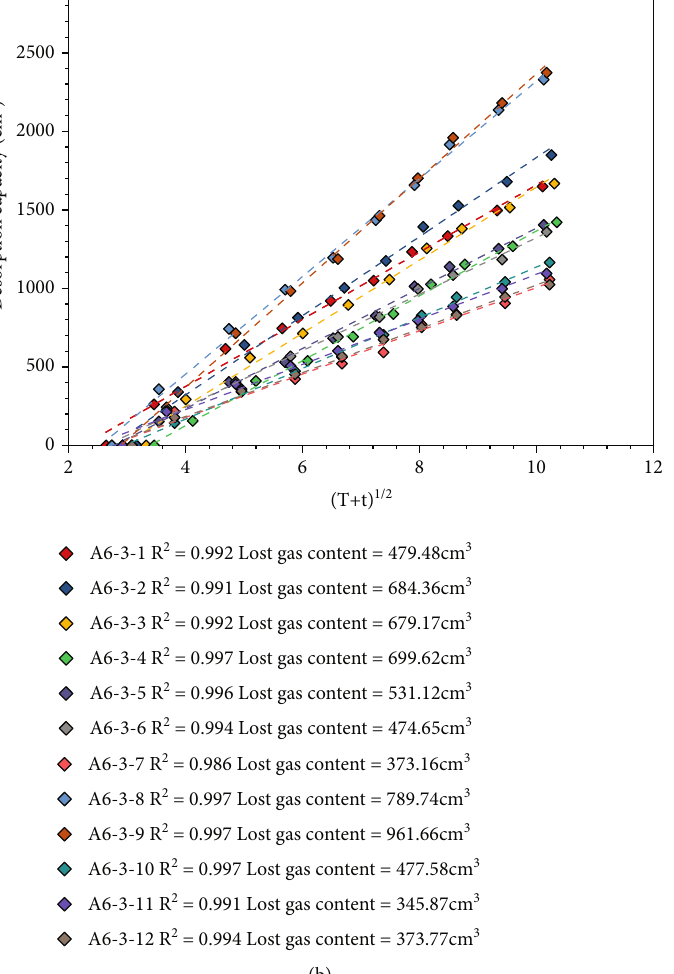
Figure 2: Desorption and CBM content calculation of coal core samples: (a) desorption of coal core samples; (b) calculation of the lost gas